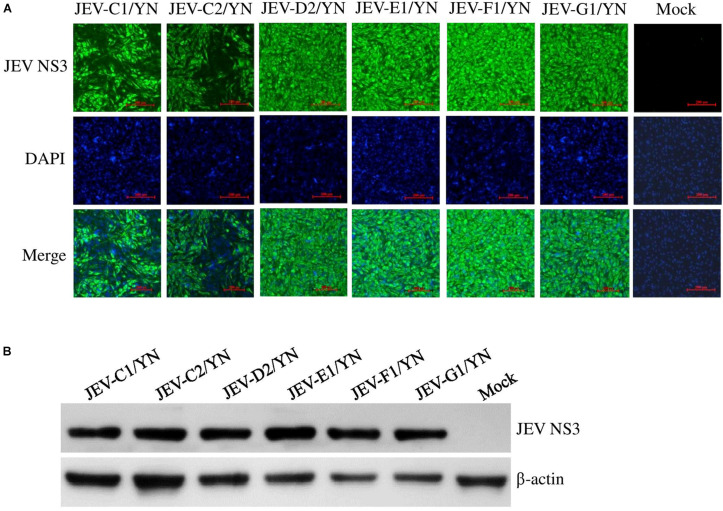
Detection of JEV in BHK-21 cells. BHK-21 cells were inoculated with the supernatants harvested from the CPE-positive BHK-21 cells inoculated with mosquito samples and incubated for 36 h. The presence of JEV was detected by IFA (A) and Western blot (B) with antibodies specific to JEV NS3 protein. Nuclei were stained with DAPI.